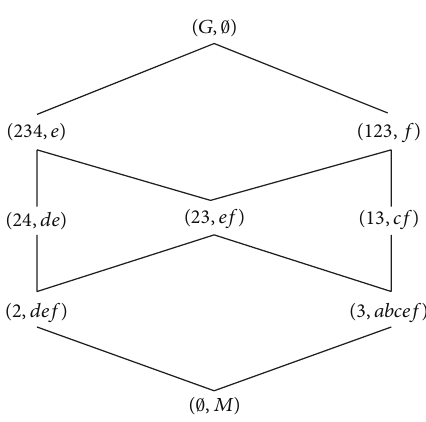
Figure 1: 𝐿(𝐺, 𝑀, 𝐼) .